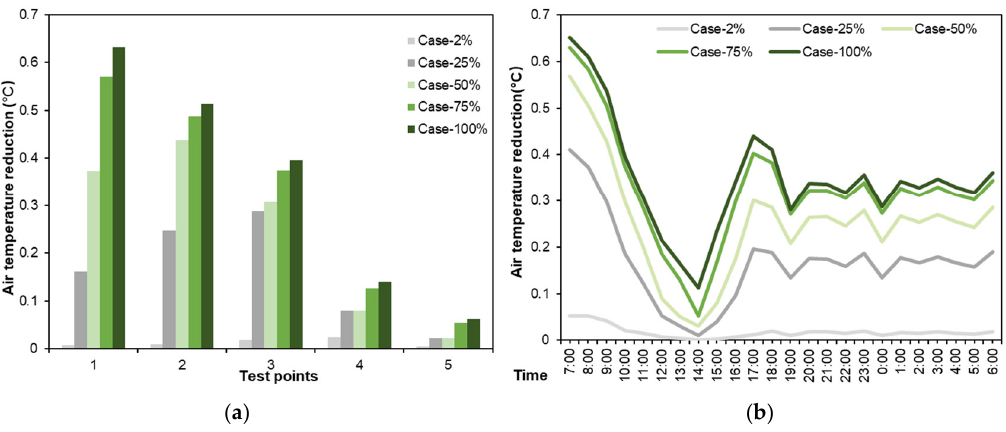
Figure 12. Average air temperature reduction in different greening coverage ratio scenarios. ( a ) Daily average air temperatures at five test points, and ( b ) daily variations of average air temperature of five test points from 07:00 to 06:00 h of the next day.